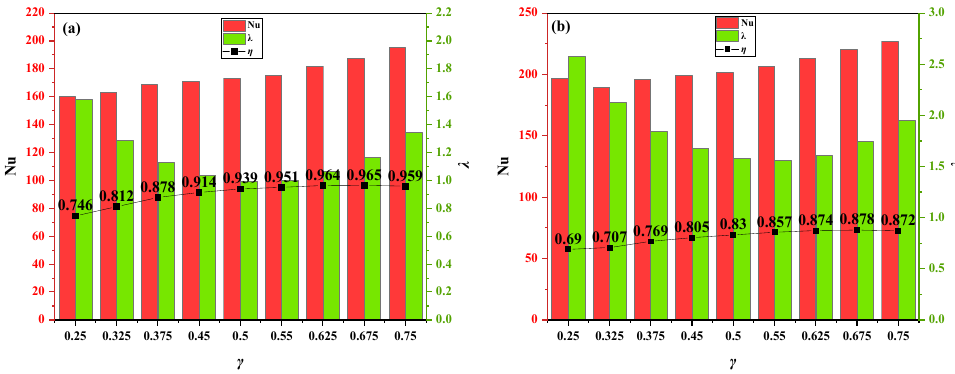
Figure 10. Effect of changing the centrosymmetric position for the same Kenics static mixer on 𝑁𝑢 ， 𝜆 , and η : (a) 𝐴𝑅 = 2.0,𝑅𝑒 = 7000 ; (b) 𝐴𝑅 = 1.5, 𝑅𝑒 = 8000 .